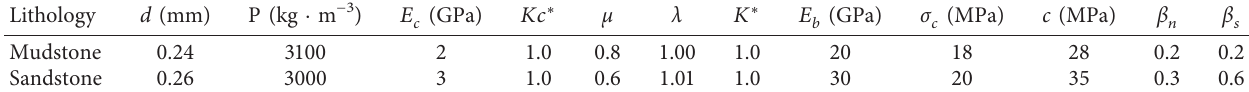
Table 2: Mesoscopic parameters of sandstone and mudstone materials.